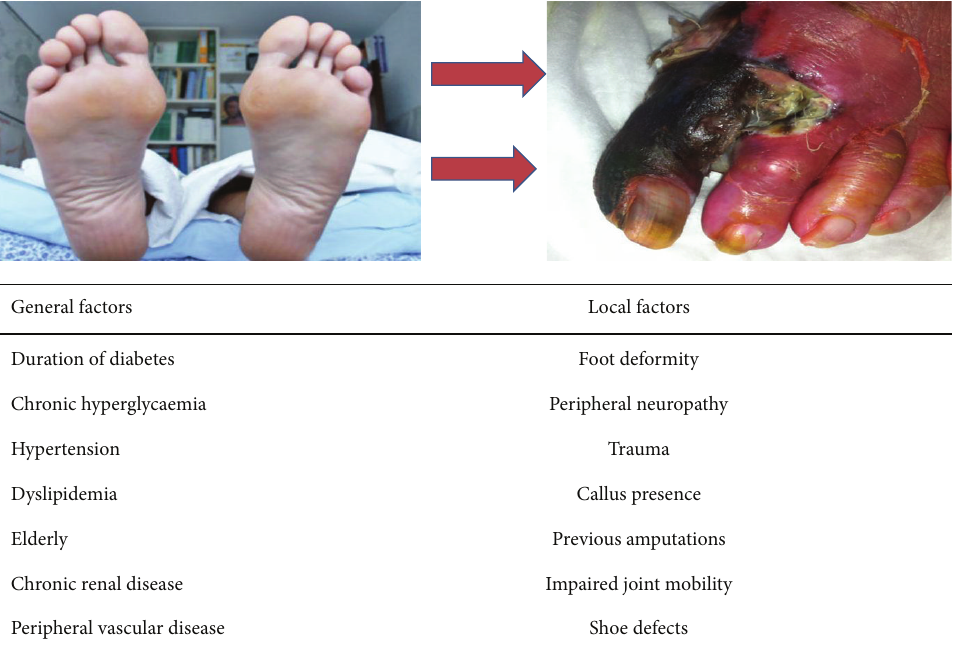
Figure 5: Evolving foot in diabetics: from healthy foot to ischemic diabetic foot.